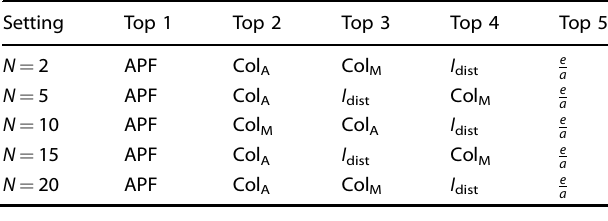
Table 5. The top 5 important factors selected by BART for the maximum bulk modulus K in MAX phases with additional non- informative features with the initial set of sample size N ∈ {2, 5, 10, 15, 20}.